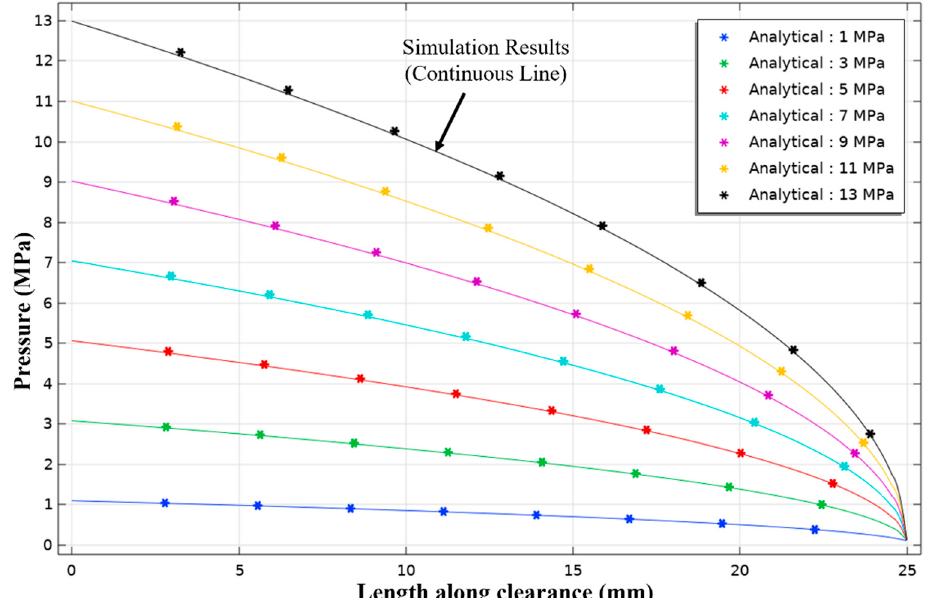
Figure 5. Comparison of the analytical solution of the pressure field with simulation for different inlet pressure conditions for the one-way coupling. The continuous lines are the results obtained from the numerical simulation, and the plots with the asterisk marker represent the analytical solution.